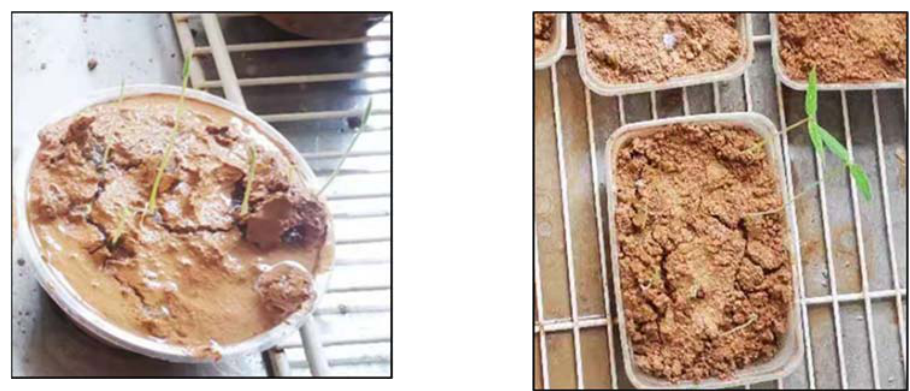
Figure 11. The expansion of water-retaining material increased the bulkiness of soil.